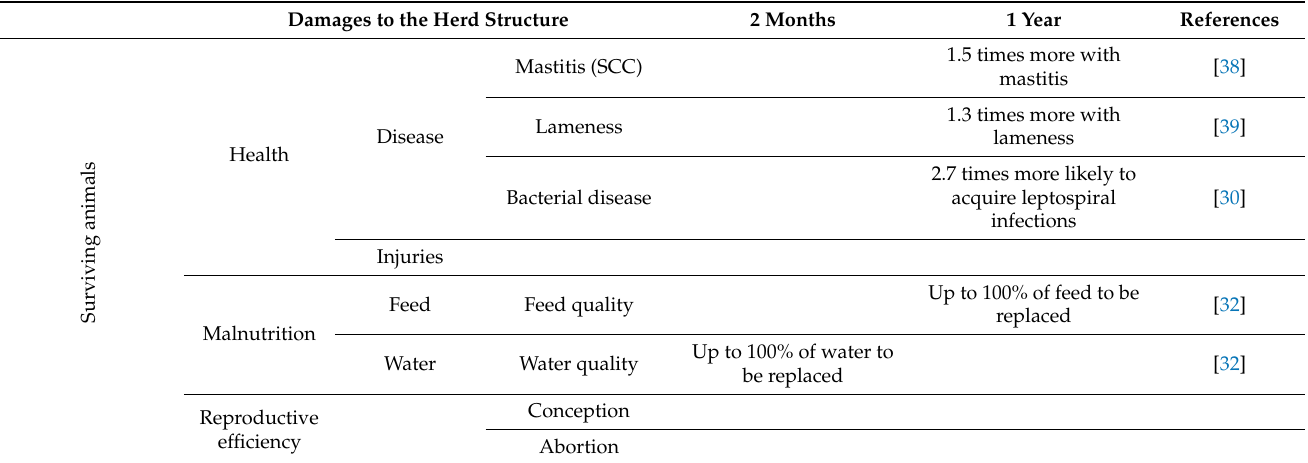
Table 3. Dimension of the damage on the